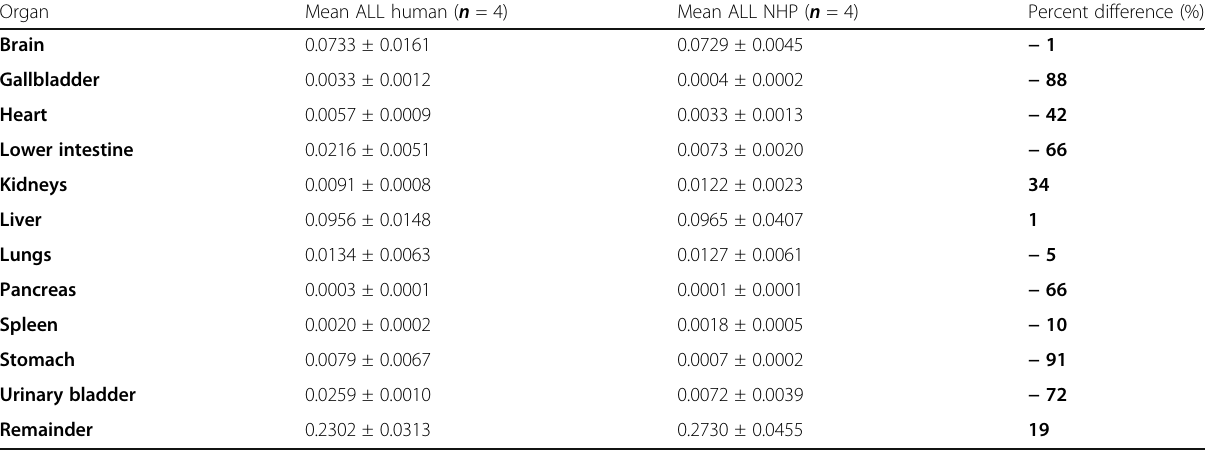
Table 3 Organ residence times (hours) of 11 C-UCB-J in humans in comparison with those in non-human primate (NHP). All values displayed as mean ± standard